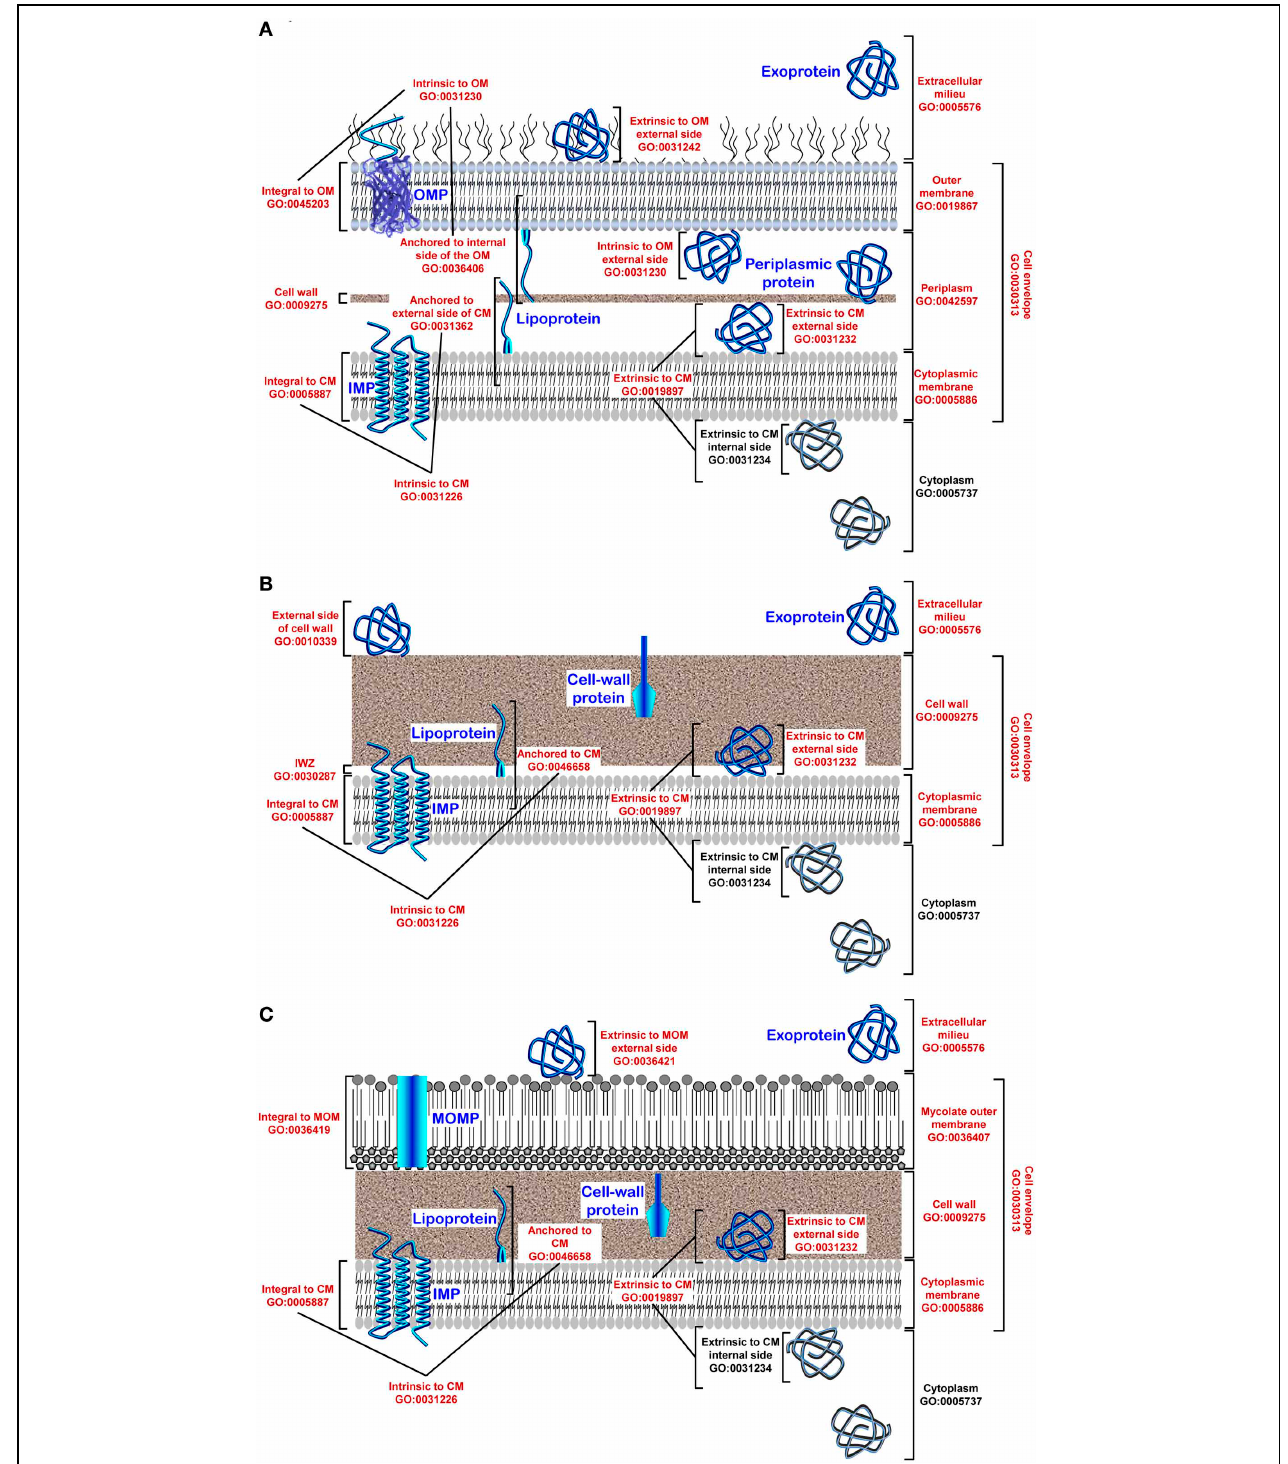
FIGURE 1 | Gene Ontology (GO) for cellular components and protein subcellular location in bacteria. (A) In diderm-LPS bacteria, five clearly defined compartments are considered (i) the cytoplasm (CP; GO:0005737), (ii) the cytoplasmic membrane (CM; GO:0005886), (iii) the periplasm (PP; GO:0042597), (iv) the outer membrane (OM; GO:0019867), and (v) the extracellular milieu (EM; GO:0005576). The cell envelope (GO:0010339) is